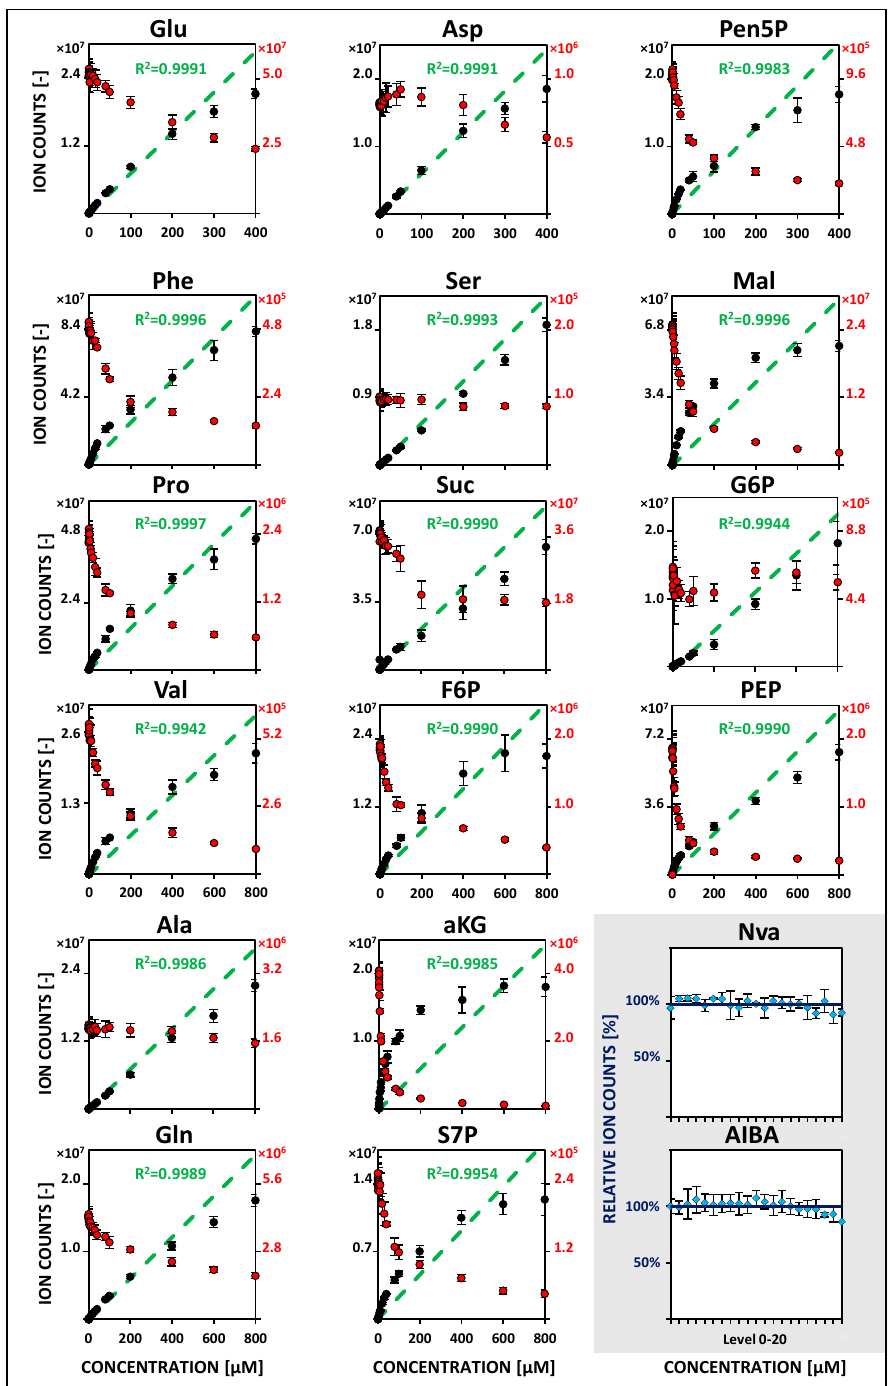
Figure 2. HILIC-based QTOF-HRMS studies in EDR mode of metabolite-specific signal responsivities using U 13 C isotope dilution (IDMS). See Table S6 for related regression parameters. See Figure 1. See Tables S1–4 for the full names of abbreviated metabolites.